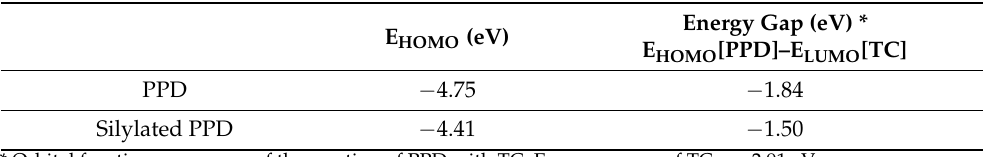
Table 2. HOMO energy values (eV) of PPD and silylated PPD. Energy gap (eV) of the reaction between PPD and terephthaloyl chloride (TC).